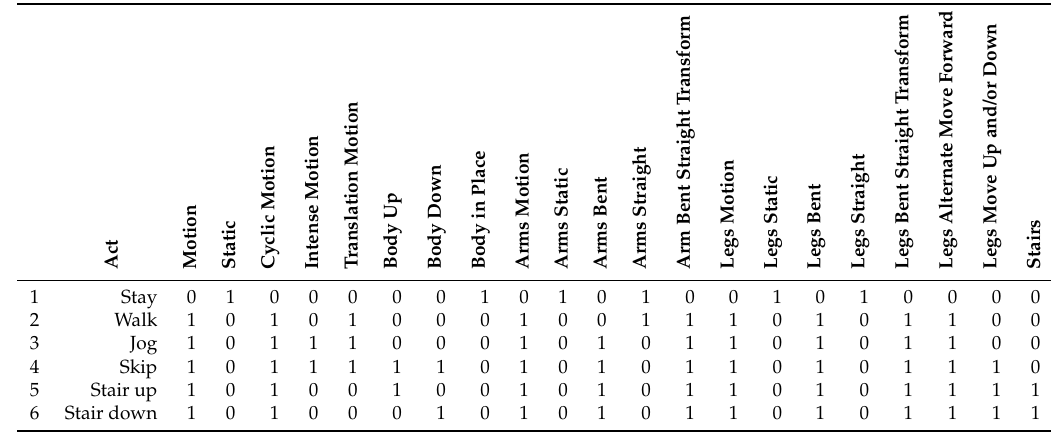
Table A1. Attribute vectors of the HASC